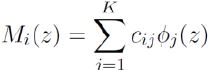
Figure 3. The division of a subsoil sample according to the concept of functional data analysis.